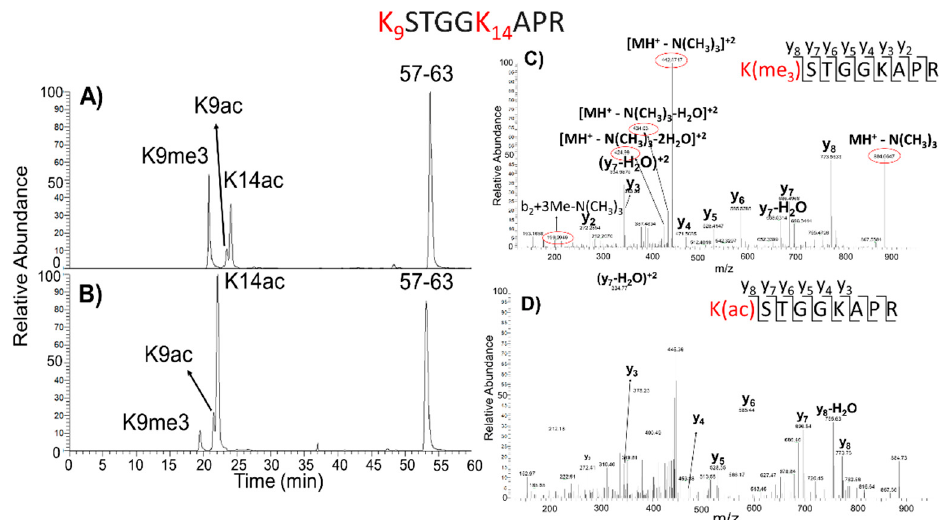
Figure 6. Extracted ion chromatogram (XIC) of tryptic peptide ion 9–17 of H3 histone from E14 mouse ES cells treated with DMSO ( A ) or TSA ( B ). Peak derived from the doubly charged 472.2867 m / z was detected as the species carrying a trimethylation on K9 (lowest RT), 472.2705 m / z corresponded to the acetyl group on K9 (middle RT), 472.2687 m / z was relative to K14 acetylated (highest RT), and reference peptides 57–63 eluting with an RT about 53 min is also reported. The fragmentation spectra of tri-methylated (Me3) ( C ) and acetylated species ( D ) are also reported. Peptide 9–17 sequence is reported upper in figure; in red K residues are highlighted, as potential targets of PTMs. In red circles, the specific daughter ions are highlighted. Me: methyl group; Ac: acetyl group.